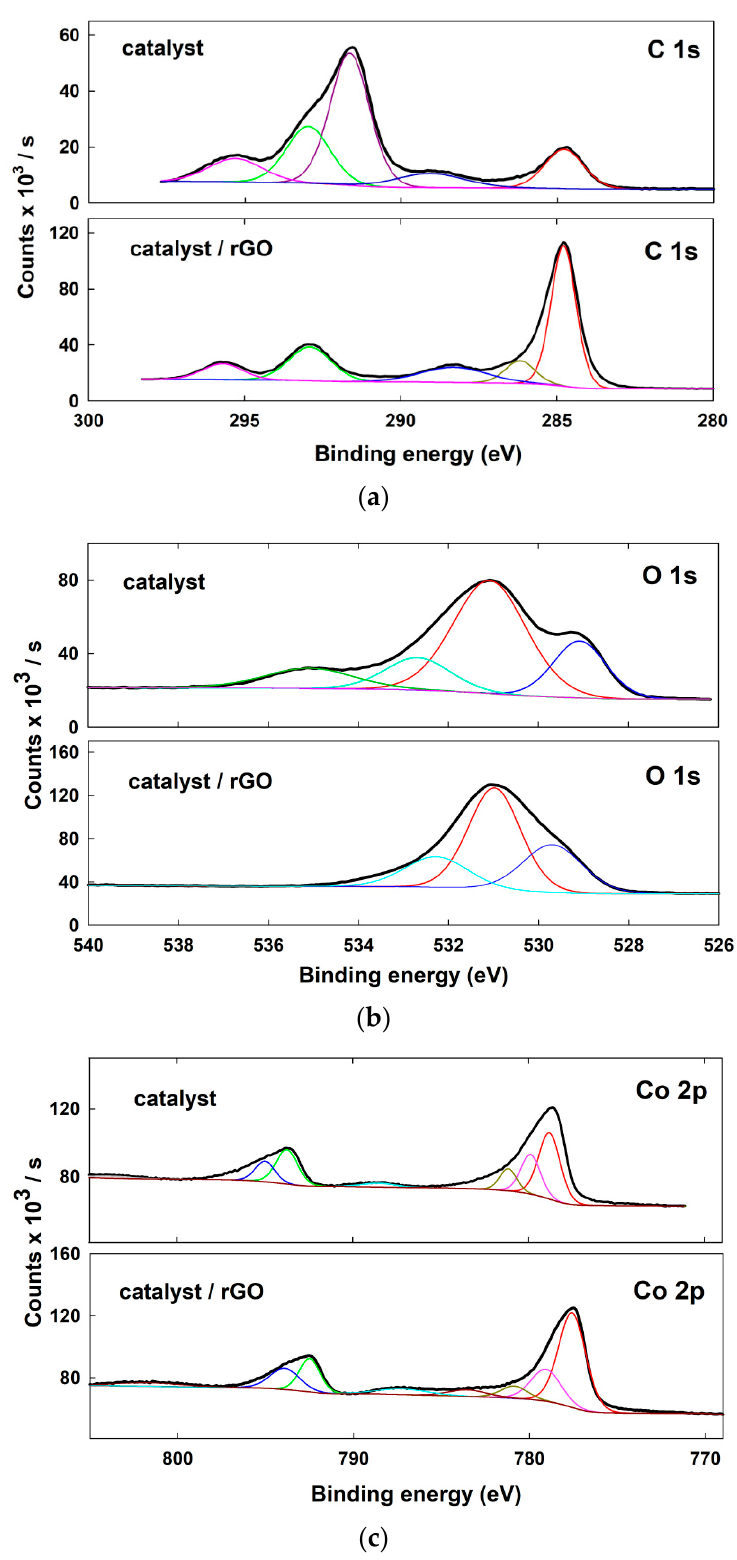
Figure 6. XPS spectra for ( a ) C 1s, ( b ) O 1s, and ( c ) Co 2p regions using the catalyst alone or the catalyst/rGO composite-modified indium tin oxide electrode after electrochemical measurements.